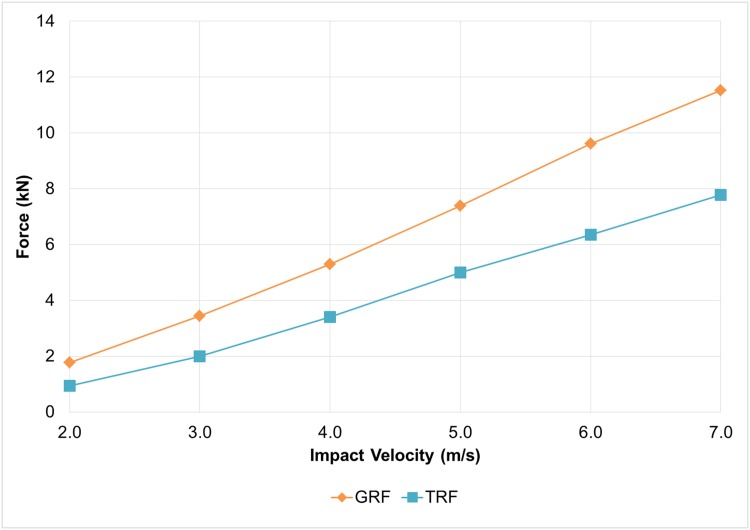
Ground reaction force (GRF) and tibial reaction force (TRF) under different impact velocity (2.0–7.0 m/s).(S2 Table).